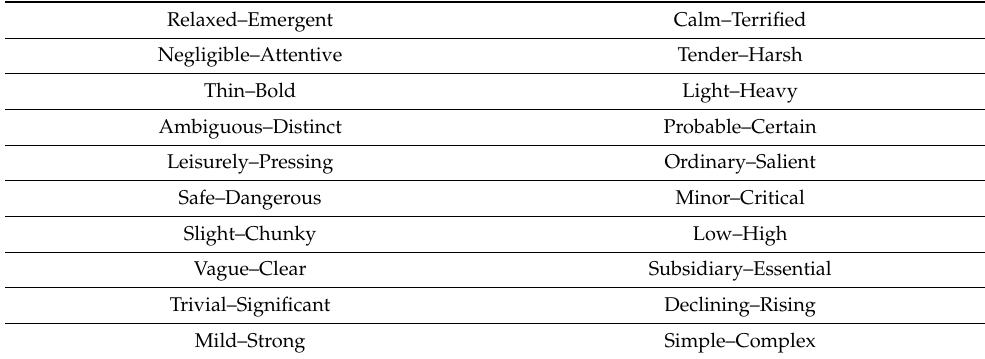
Table 2. Kansei words used in the experiment.